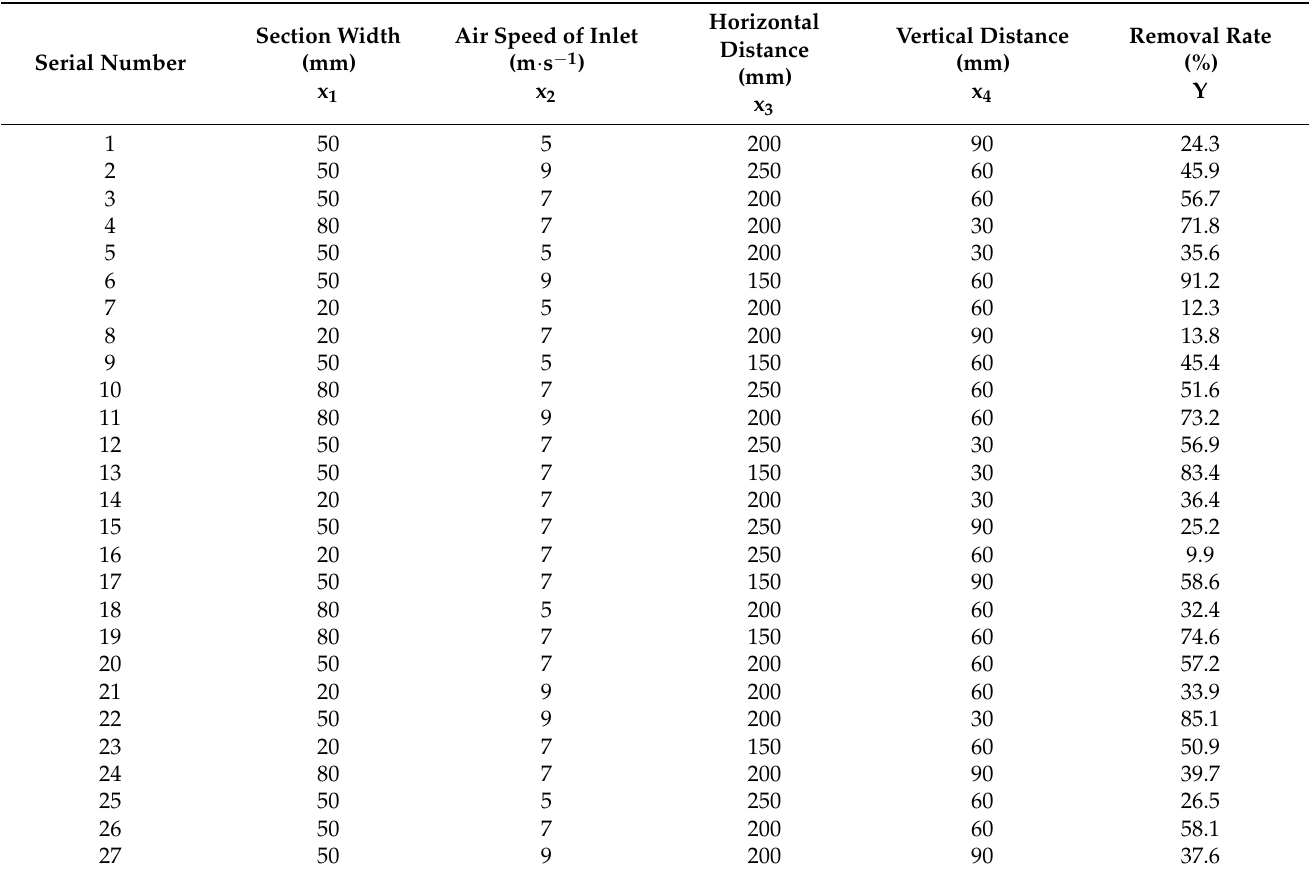
Table 4. Experimental design scheme and